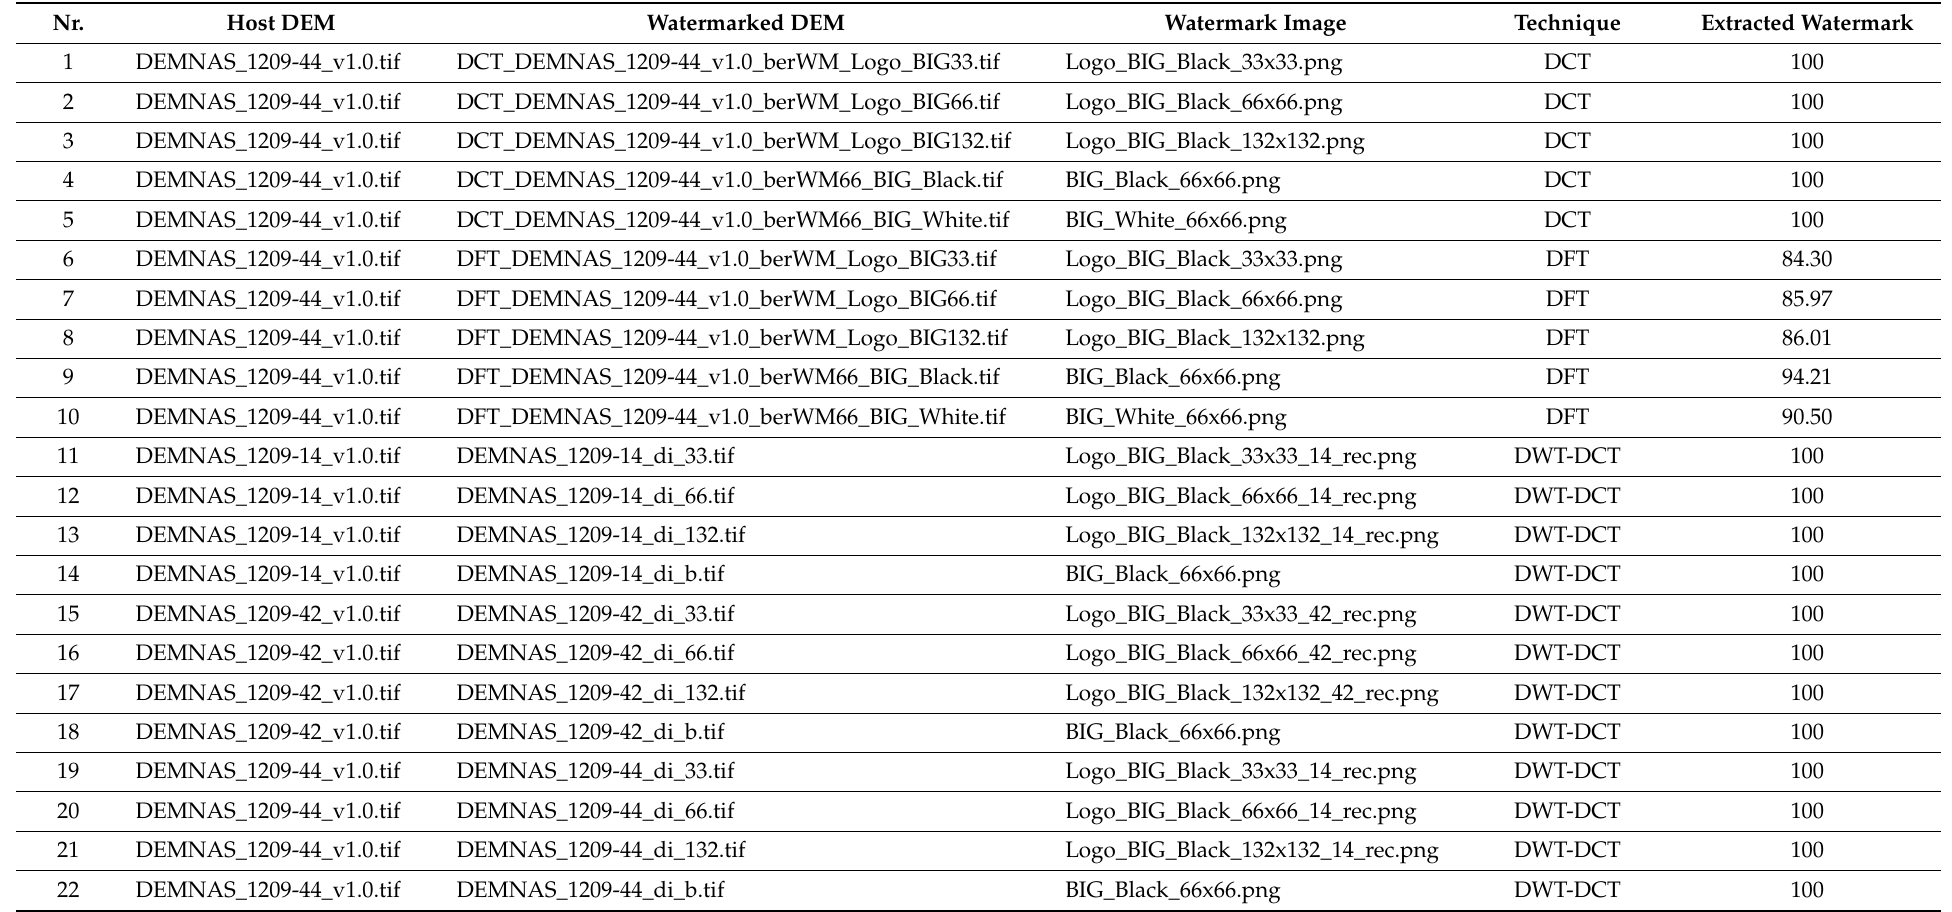
Table 7. Experimental results of the evaluation parameter of extracted